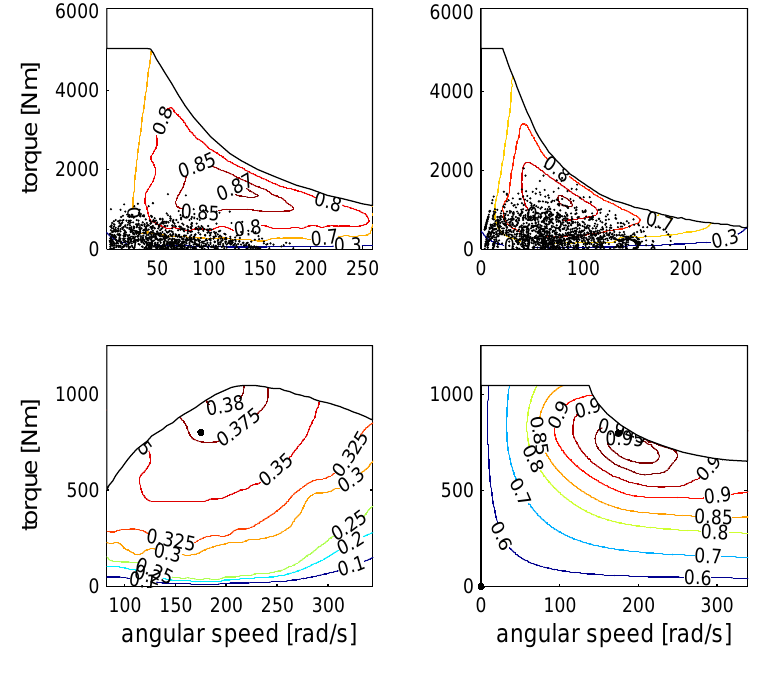
Figure 13. Usage maps of the HEV machines (enabled air cooling system).